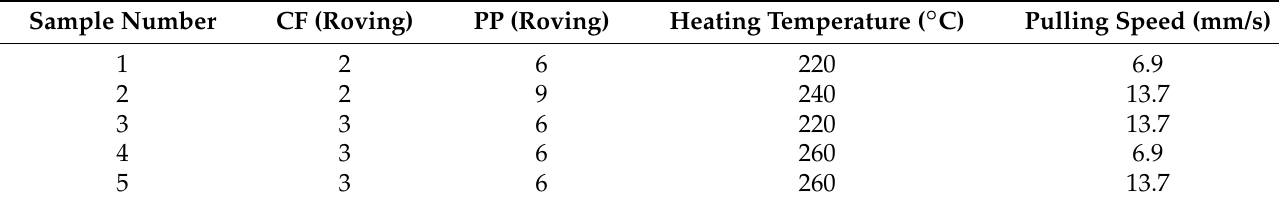
Table 2. Planing of the experimental tests.